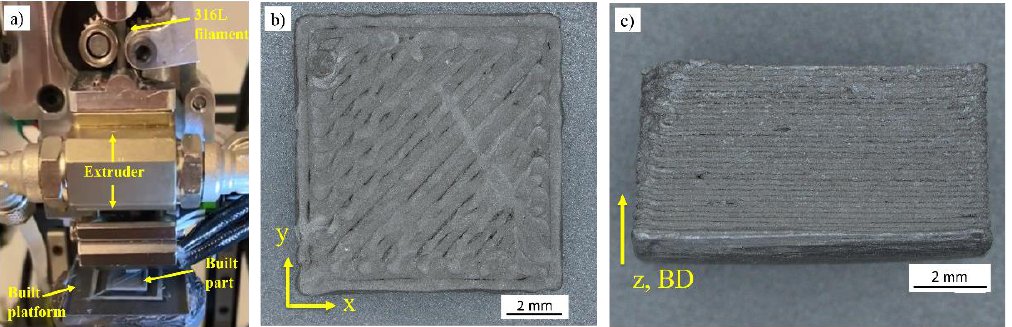
Figure 4. ( a ) Custom in-house FFF machine shaping a geometry, ( b ) XY plane of AB green parts and ( c ) Z-BD plane. ( c ) Z-BD